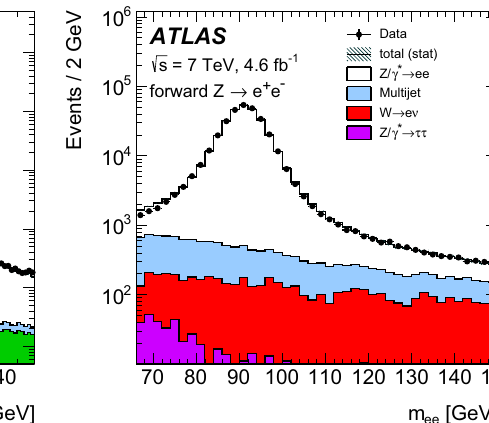
Fig. 7 The dilepton invariant mass distributions for Z /γ ∗ → e + e − candidates with two central electrons ( left ) and one central and one for- ward electron ( right ). The simulated samples are normalized to the data luminosity. The multijet background shape is taken from a data control sample and normalized to the estimated yield of multijet events. The